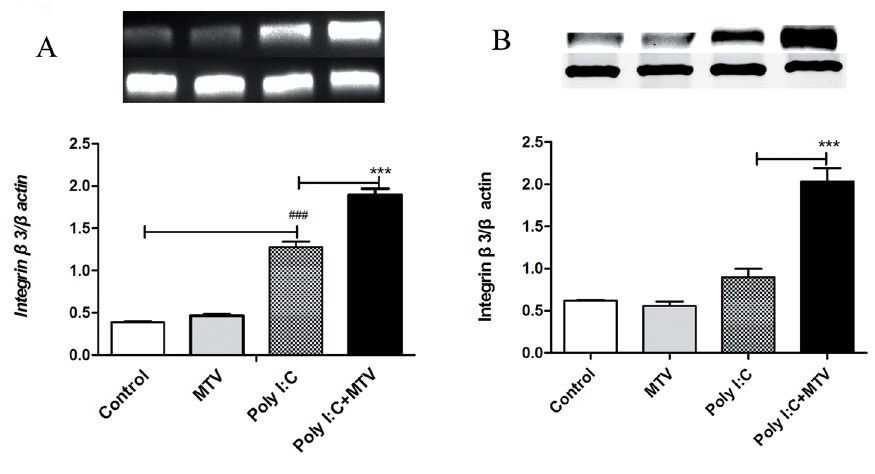
Figure 5. Alterations in pulmonary levels of integrin b 3 mRNA expressed as (A) the ratio to the housekeeping gene β -actin and protein and (B) the ratio to the housekeeping protein β -actin at 4 h after poly(I:C) and MTV treatment. Data are presented as means ± SEM (n = 15) and compared by one-way ANOVA and Student-Newman-Keuls test. For comparing the poly(I:C) group and MTV group with the untreated control group: ### P < 0.001. And for comparing the poly(I:C) + MTV group with the poly(I:C) and MTV groups: *** P <